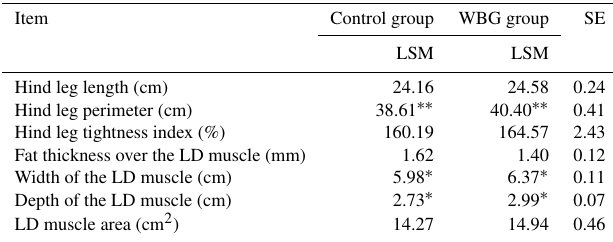
Table 3. The hind leg and LD muscle measurements and traits for the control and the WBG lambs. Item